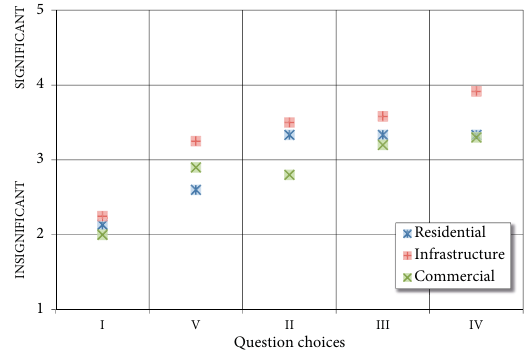
Fig. 9. Significance of external business factors based on main activity areas